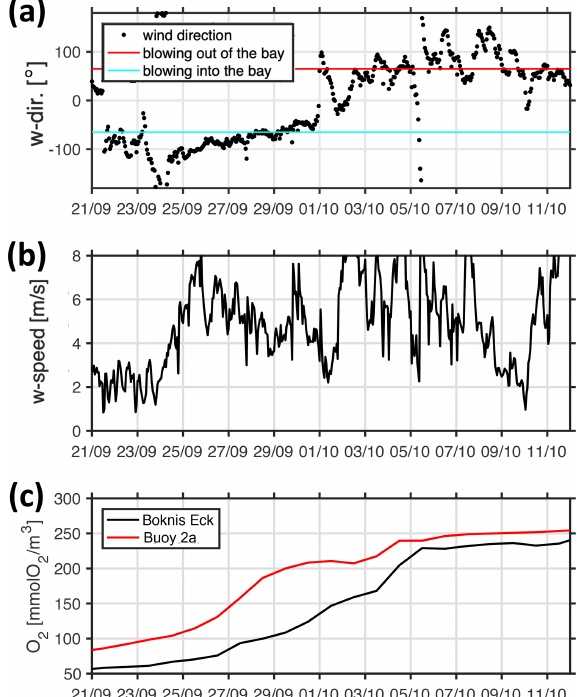
Figure 17. Simulated temporal evolution of (a) wind direction, (b) wind speed, and (c) bottom oxygen concentrations during the relax- ation phase that terminates the 2017 hypoxic event. The black and red lines in panel (c) refer to station Boknis Eck at the entrance and station Buoy 2a deep inside EB, respectively.